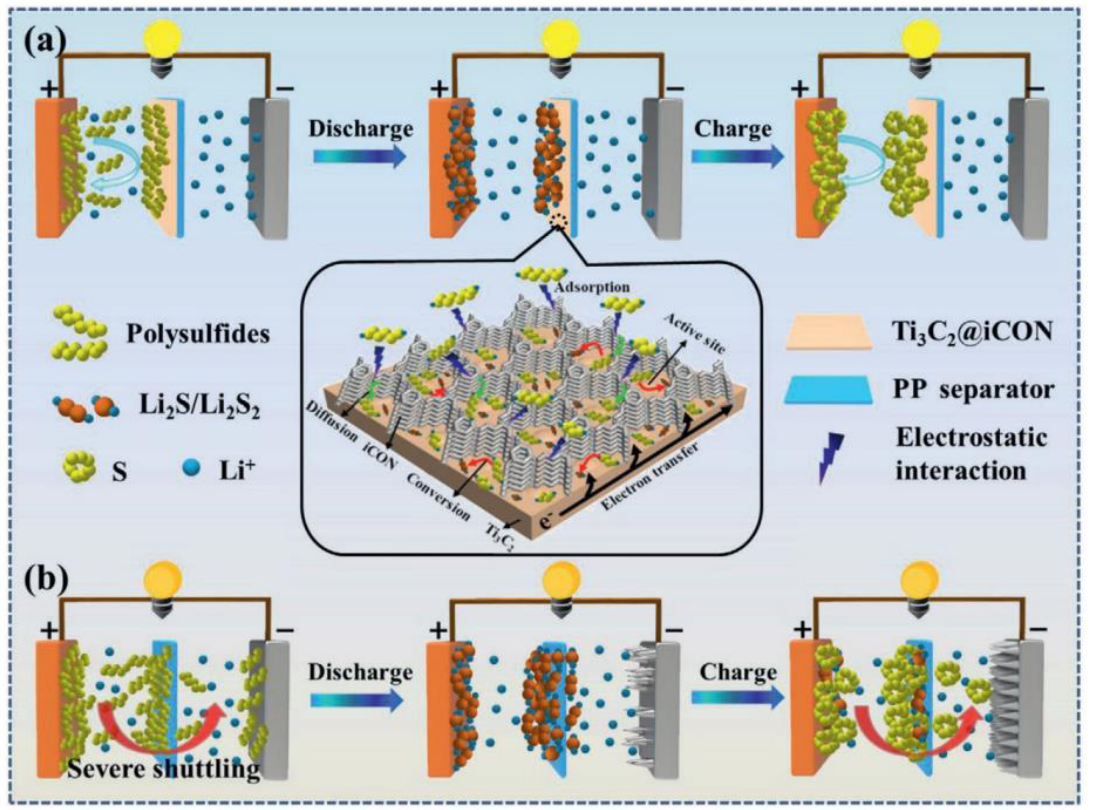
Figure 6. Schematic illustrations of polysulfide trapping and conversion process on ( a ) Ti 3 C 2 @iCON-PP ( b ) and Ti 3 C 2 -PP. Adapted with permission [30]. Copyright 2021, John Wiley and Sons.